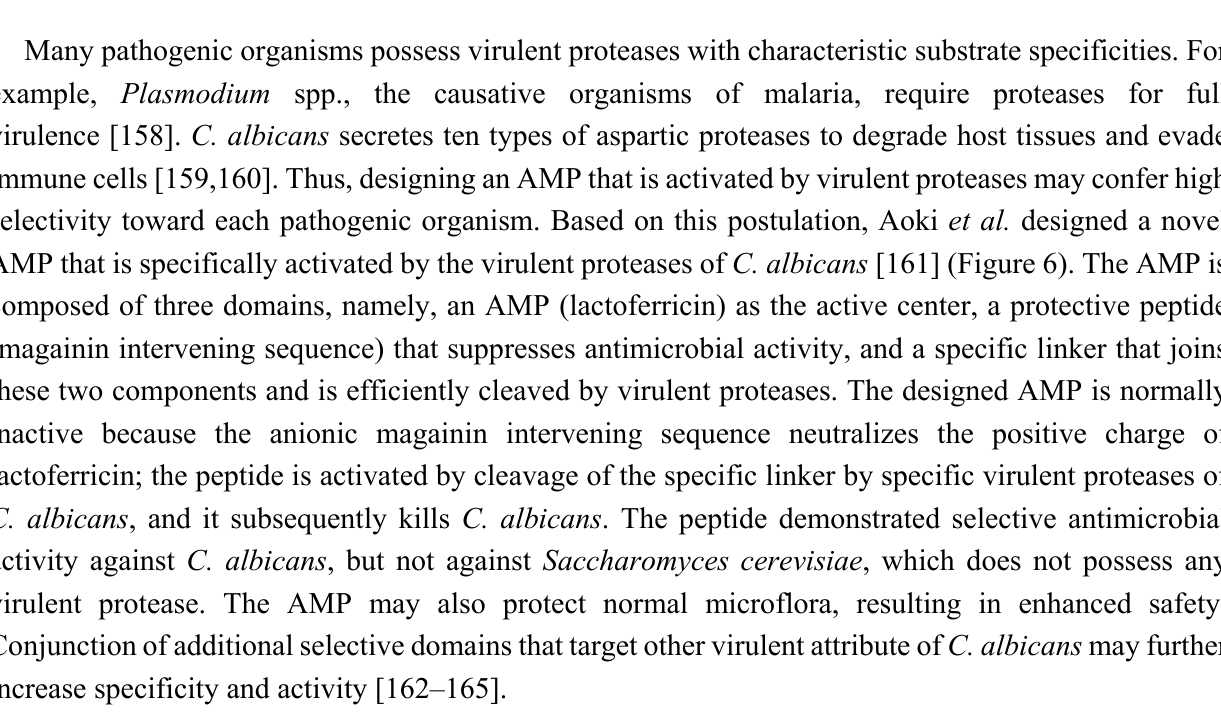
Figure 6. Protease-activated AMP (Table 1). The peptide is composed of three domains: an AMP, a protective peptide, and a specific linker. The antimicrobial activity of the AMP is inhibited by conjunction with the anionic protective peptide. Virulent proteases cleave the specific linker and release the AMP, leading to its